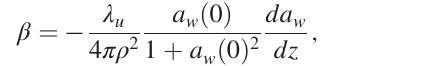
with the untapered planar undulator configuration (Fig. 1, red box) before the reverse tapered planar undulator. Our proposal (which is named “ the modified reverse tapering method ” ) can be described as the combination of the untapered planar undulators (red box) and the existing method (black box).